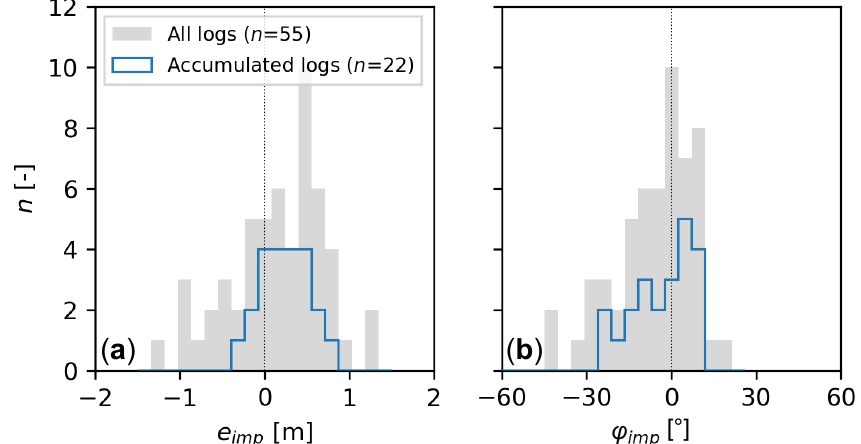
Figure 7. Histograms of ( a ) log impact eccentricity e imp and ( b ) impact yaw ϕ imp